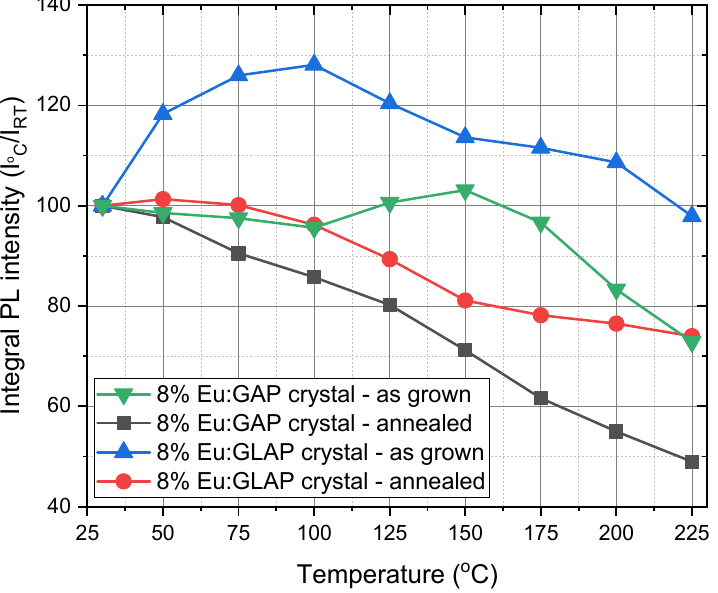
Figure 7. Temperature dependence of PL integral intensity of Eu:GAP and Eu:GLAP crystals with or without post Ar (+5% H 2 ) annealing process, λ ex = 275 nm.